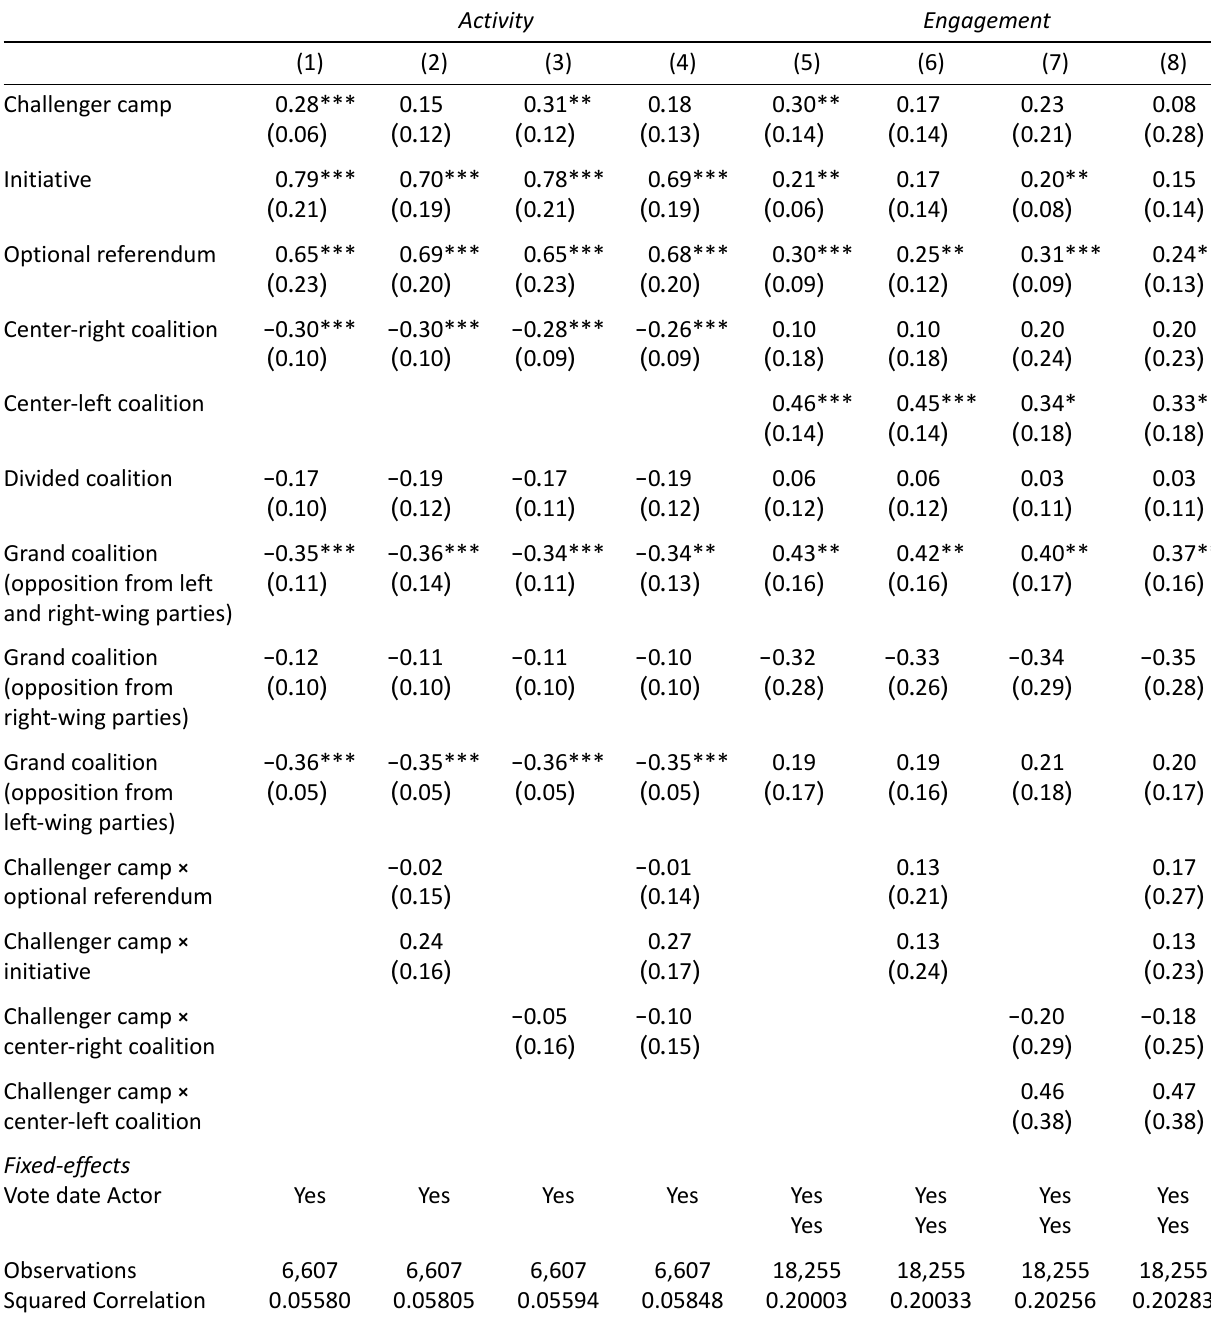
Table 1. Quasi‐poisson regression analysis of predictors for Facebook activity and user engagement (standard errors clus‐ tered on vote